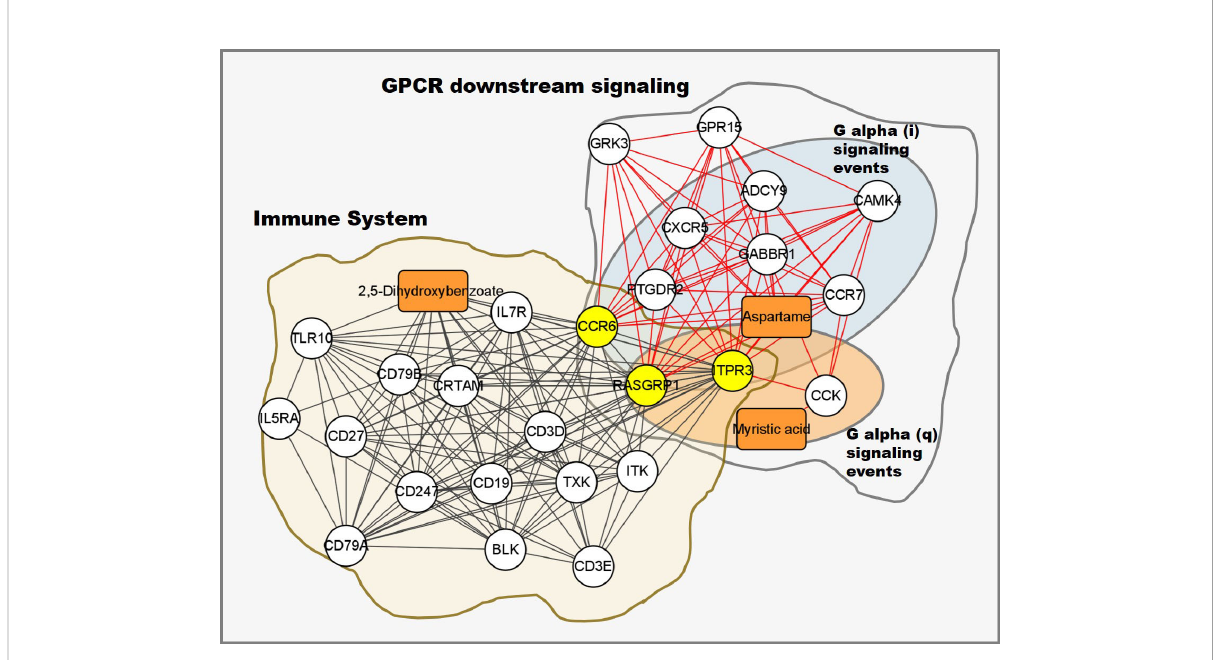
FIGURE 9 Integrated transcriptomic and metabolomic response network to PRRSV infection. Each node represents a signi fi cant correlation (|r| > 0.3 & p- value < 0.05), box represents metabolite, circle represents gene, the shared genes between immune system and GPCR downstream signaling pathways colored in